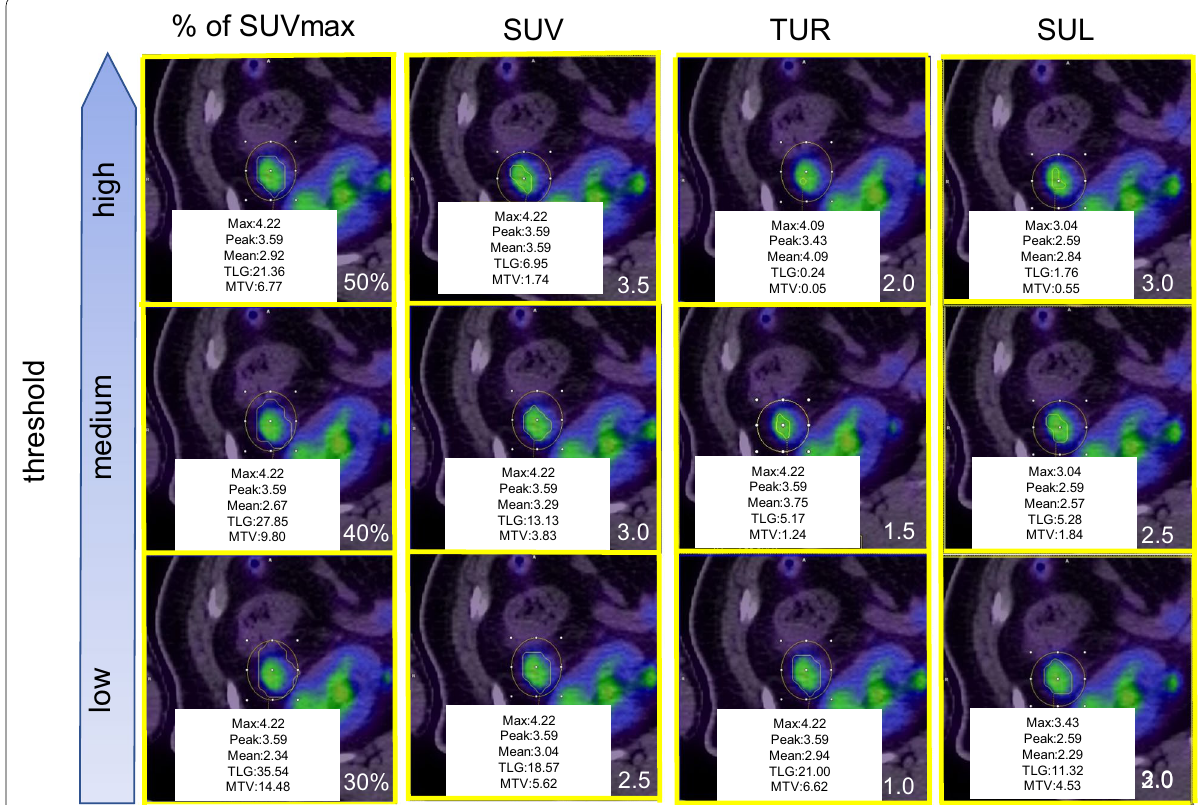
Fig. 2 Thresholds in case of a lower SUVmax tumor. SUVmax: maximum standardized uptake value, SUV peak: peak standardized uptake value, SUV mean: mean standardized uptake value, MTV: metabolic tumor volume, TLG: total lesion glycolysis, TUR: tumor-to-liver uptake ratio, SUL: SUV normalized to lean body mass; VOI: volume of interest. VOIs for TUR2 were smaller than in other thresholds. VOIs in % of SUVmax were larger than in other thresholds. For each threshold, the lower the value, the larger the